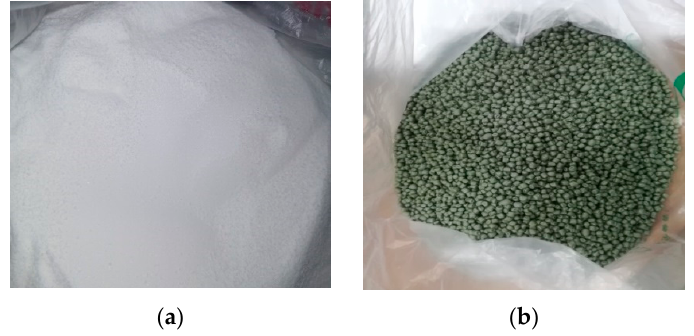
Figure 1. High modulus modifiers: ( a ) Honeywell7686; ( b ) Lubao.